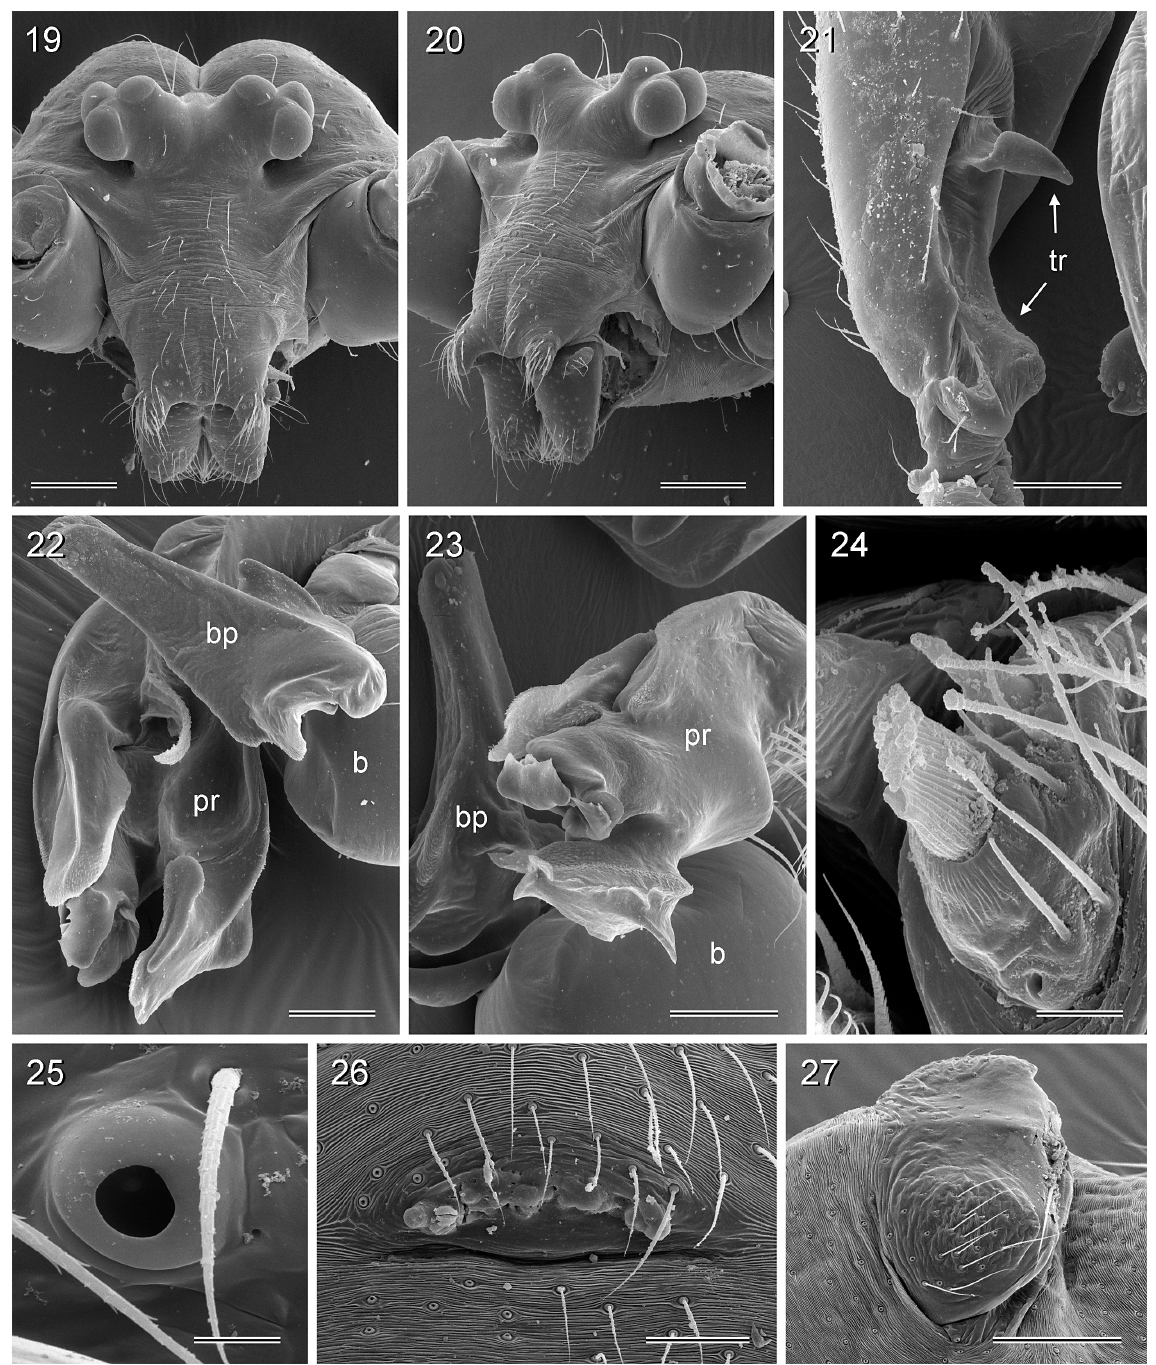
Figs 19–27. Savarna kaeo sp. nov. 19–20 . Male prosoma, frontal and oblique frontal views. 21 . Right male palpal trochanter (tr) and femur, retrolateral view. 22 . Left procursus (pr) and bulbal process (bp), prolatero-distal view (b = bulb). 23 . Right procursus (pr) and bulbal process (bp), retrolatero-distal view (b = bulb). 24 . Female ALS. 25 . Male palpal tarsal organ. 26 . Male gonopore. 27 . Epigynum, ventro- lateral view. Scale bars: 24–25 = 10 µm; 26 = 80 µm; 21–23 = 100 µm; 19–20, 27 = 200